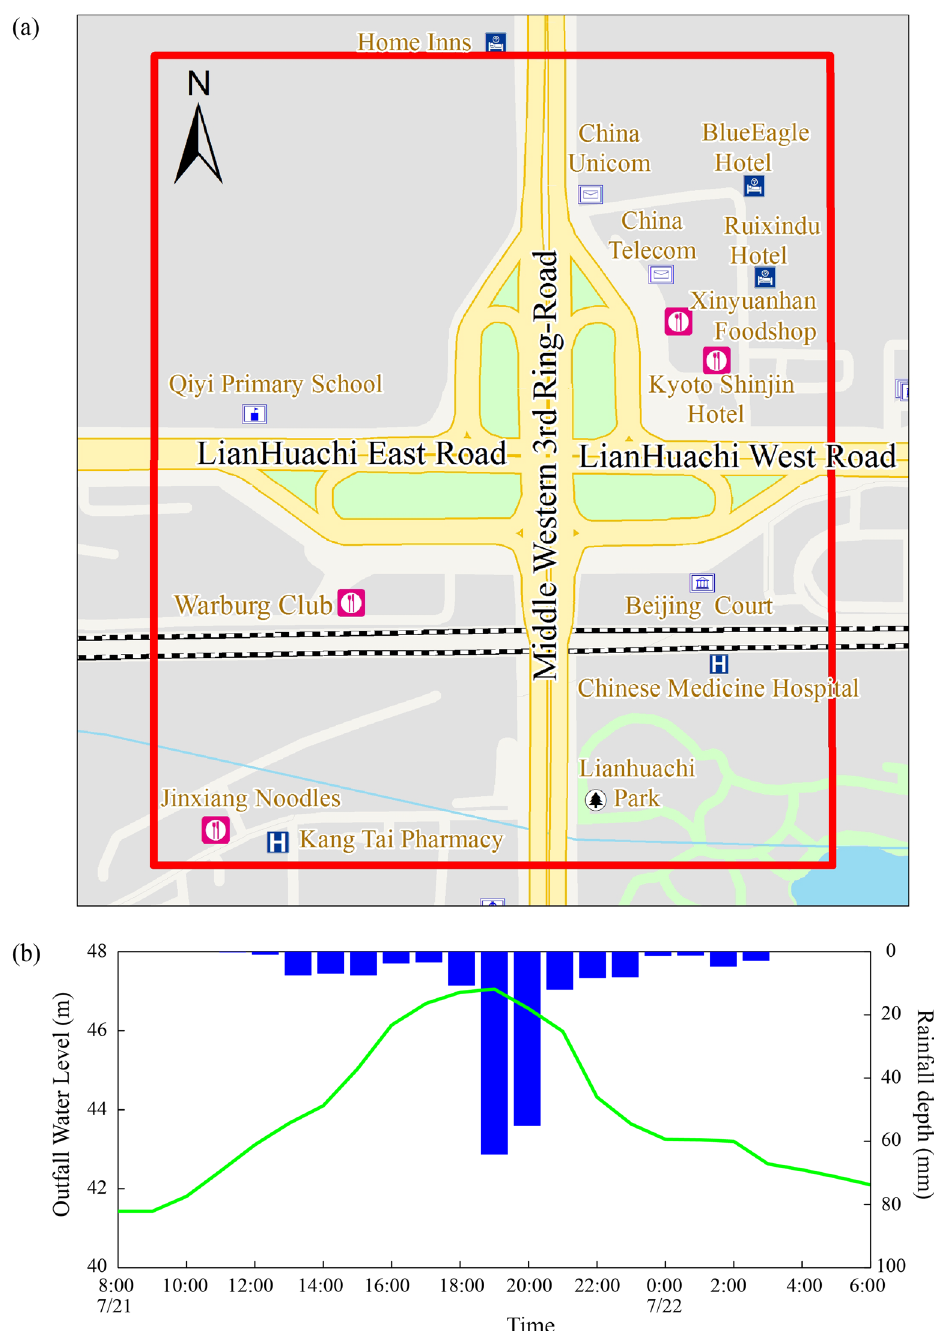
Figure 7. ( a ) The location of the study area is indicated by the red lines. ( b ) The outfall boundary condition for the 21st July rainfall event. The recorded water levels at Liangshui river are represented by the green line, and the recorded hourly rainfall depth is represented by the blue